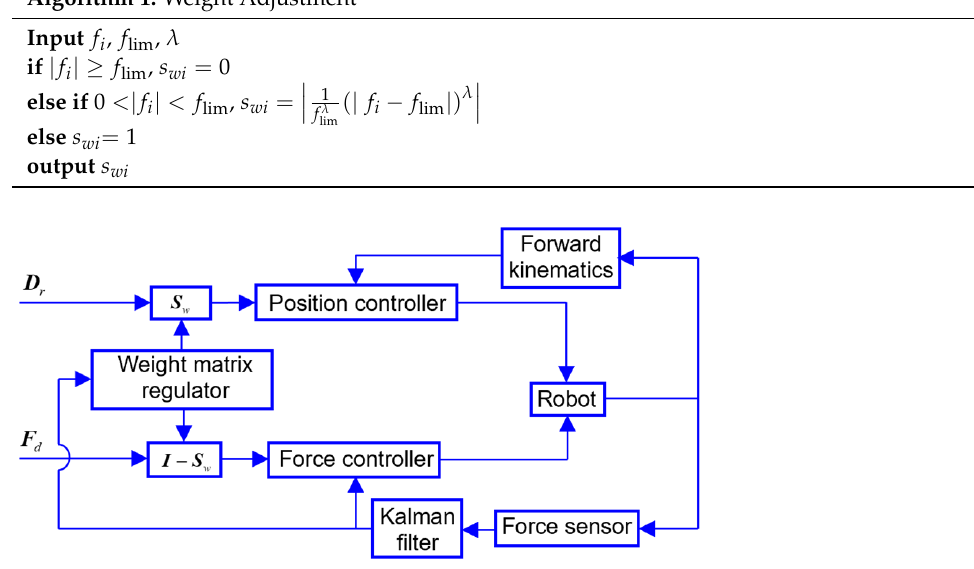
Figure 2. Control block diagram of the proposed CFPC method.